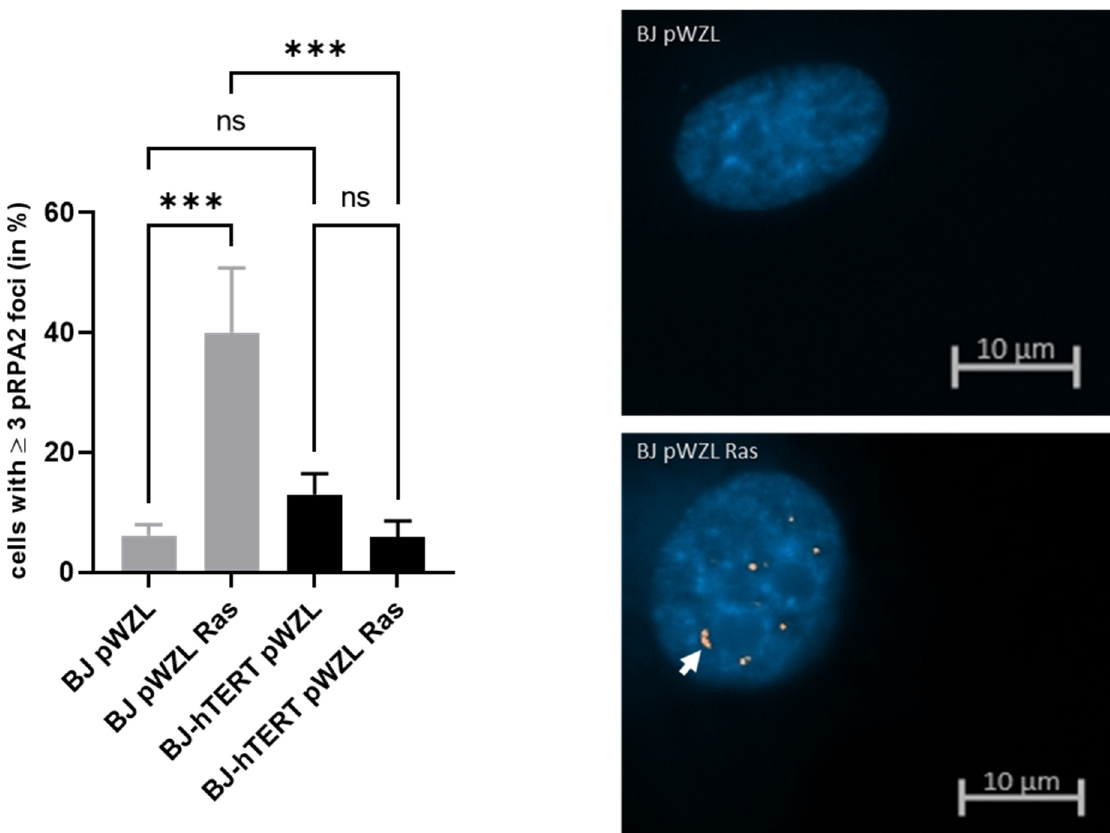
Figure 1. Evaluation of pRPA2 foci formation upon oncogene-induced replication stress. ( Left ) The bar plot displays the impact of ectopic H-RASG12V on pRPA2 foci formation in BJ and BJ-hTERT cells. pWZL represents the empty vector control. One-way ANOVA test was applied, followed by a Fisher’s LSD post hoc test, with a confidence interval of 95%. ( Right ) Representative images of BJ-pWZL (top) and BJ pWZL-RASG12V (bottom) are shown. A total of 210 cells were counted from n = 6 independent experiments. The representative pictures show DAPI-stained nuclei with nuclear pRPA2 foci (white arrow). ns ( p > 0.05), *** ( p ≤ 0.001).